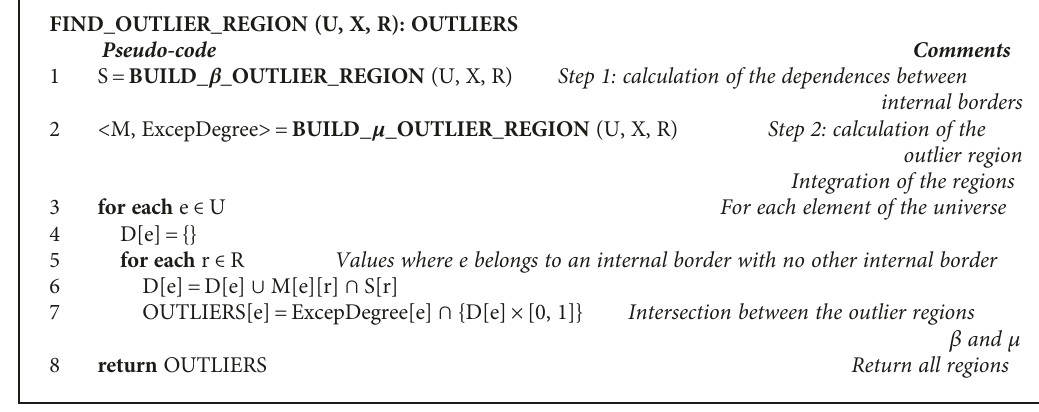
Algorithm 3: Pseudo-code of the FIND_OUTLIER_REGION algorithm. Table 1: Calculation of the spatial and temporal complexity of the FIND_OUTLIER_REGION algorithm by calculating the complexities of each structure of each component algorithm.